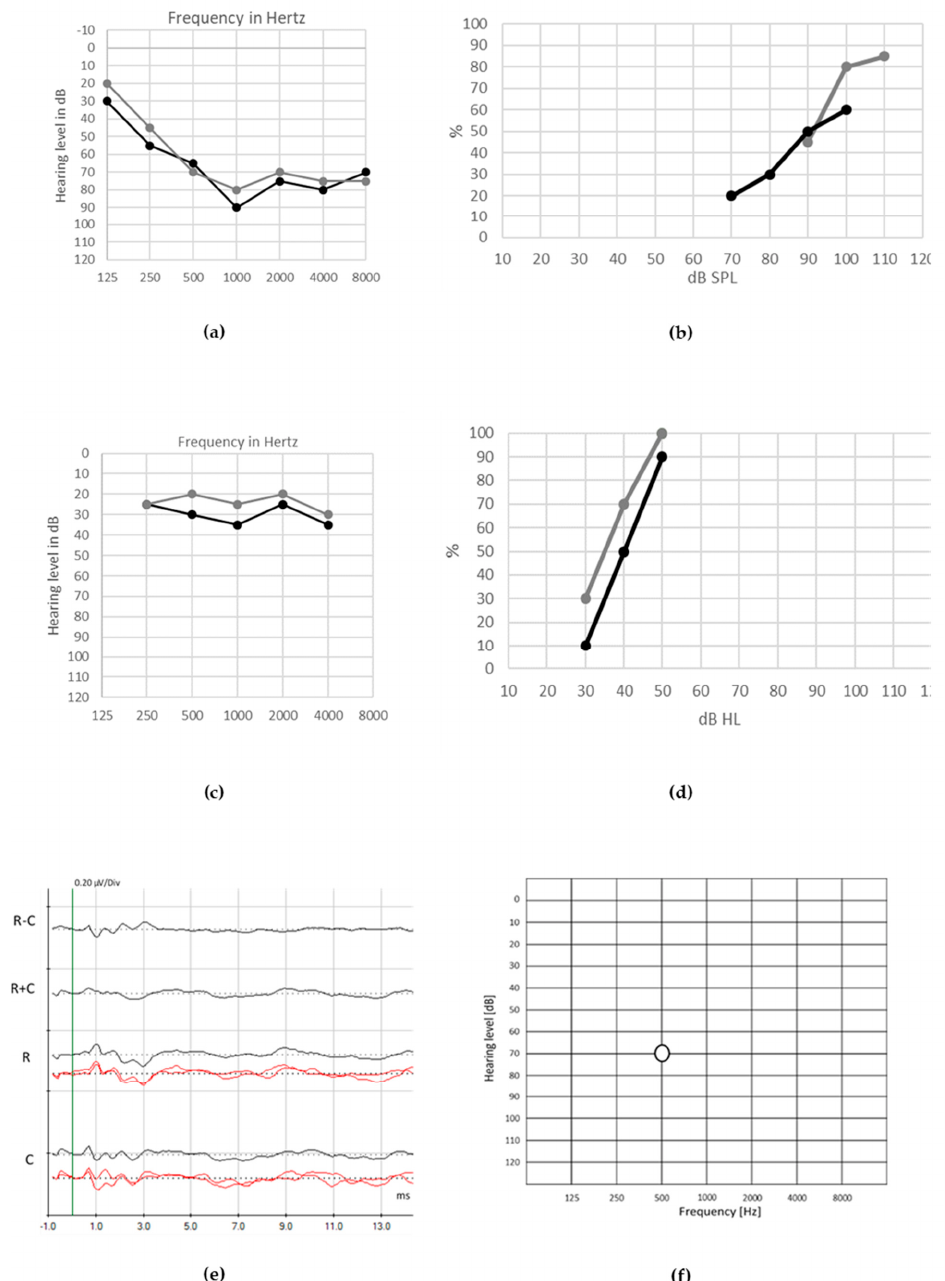
Figure 8. Audiological assessment in a 14-year-old child with auditory neuropathy spectrum disorder (ANSD) features occurring with severe hearing loss. Her medical history includes a 35-week preterm birth after an intrahepatic cholestasis of pregnancy, with normal birth weight but neonatal hypoxia requiring 3 weeks of stay in neonatal intensive care unit. Hearing aids were fitted in early infancy. Besides poor sounds recognition and speech perception, speech development was good in the lexical and morphosyntactic fields. Unaided tonal thresholds (( a ), gray line for right ear, black line for left ear) and unaided speech discrimination ( b ) are poor. Aided pure-tone audiometry ( c ) and speech perception ( d ) with hearing aids are clearly improved, allowing a good development of language skills and learning abilities. Auditory brainstem responses (ABRs) elicited by clicks at 90 dB show small cochlear microphonic (CM) ( e ). Auditory steady-state responses (ASSRs) ( f ) are detected for 500 Hz at the right